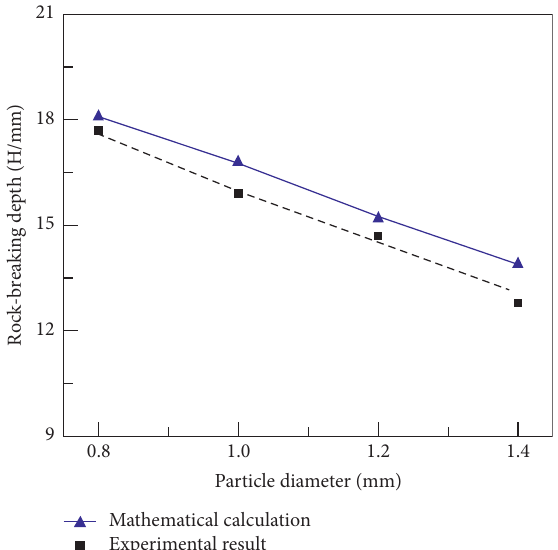
Figure 12: Effect of particle diameter on rock-breaking depth (test time with 10s; water-jet impact velocity with 205m/s; impact angle with 8 °